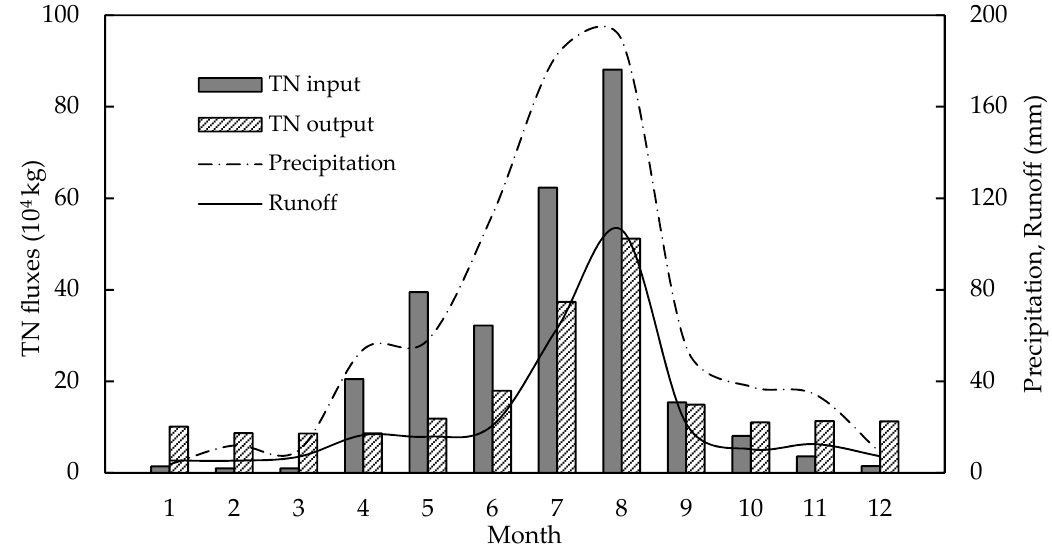
Figure 6. Seasonal variations of precipitation, runoff, and TN fluxes.